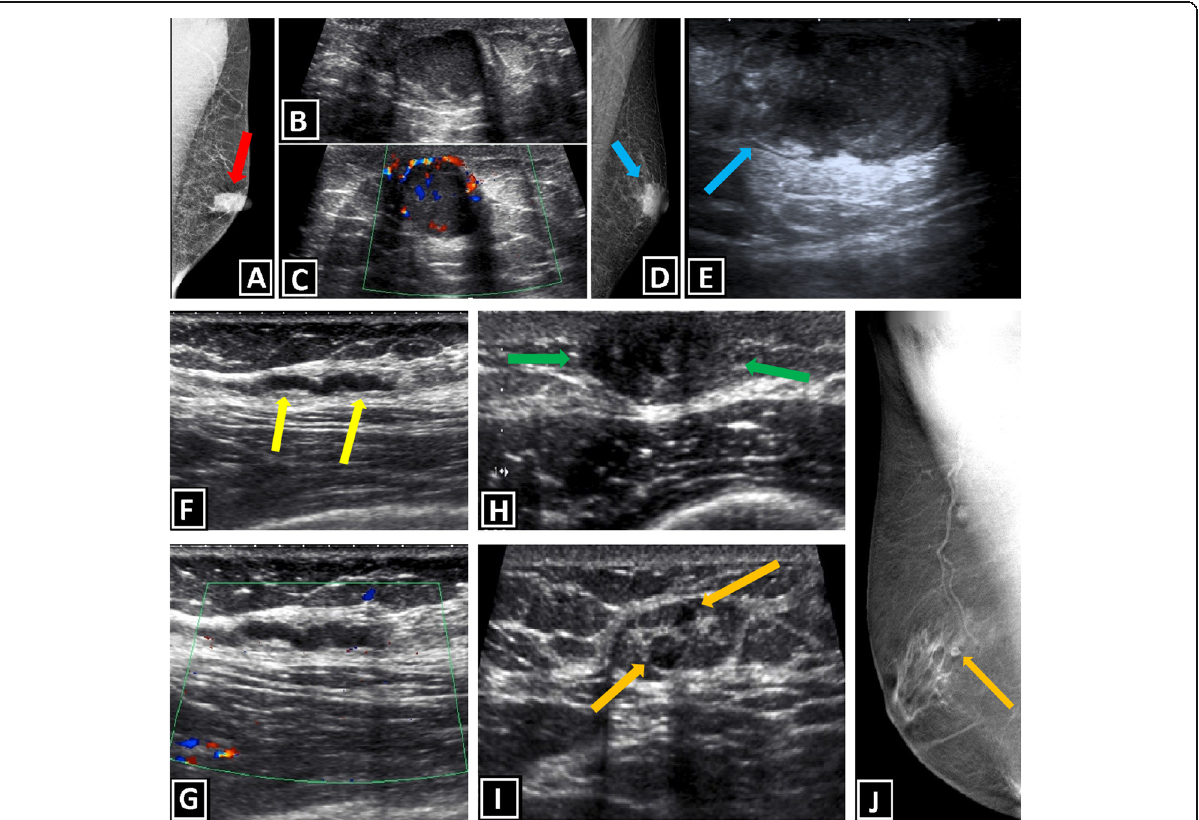
Fig. 10 Benign non-neoplastic breast lesions. a – c Fat necrosis and periductal mastitis. Mammography of a 44-year-old man with the complaint of left retroareolar pain shows circumscribed retroareolar lesion with high density (red arrow, a ). Well-defined, round hypoechoic lesion with internal and peripheral vascularity is seen in US ( b , c ). Biopsy reveals the diagnosis. d , e Subareolar abscess secondary to ruptured folliculitis. Mammography of 64-year-old man with retroareolar mass and skin erythema shows subareolar lesion with spicular margins and high density (blue arrow, d ). US for exclusion of malignancy reveals heterogeneous, hypoechoic mass which has cystic component with internal echogenities and irregular walls (blue arrow, e ). Increased vascularity in surrounding tissues is also present (not shown). Pathologic examination of mastectomy material reveals the diagnosis. f , g Mondor ’ s disease. US and Doppler US examinations of 32-year-old patient with localized right breast pain show “ beaded tubular vascular structure with irregular walls and minimally increased peripheral echogenicity, without apparent blood flow ” at the symptomatic area (yellow arrows, f ). h Duct hyperplasia. Retroareolar well-defined hypoechoic lesion is shown in a 41-year-old man with nipple discharge (green arrows). i Two small intramammary lymph nodes with circumscribed margin and round shape are shown (orange arrows). j Breast tomosynthesis of another patient reveals gynecomastia accompanied by intramammarian lymph node with round shape and radiolucent fatty hilus (orange